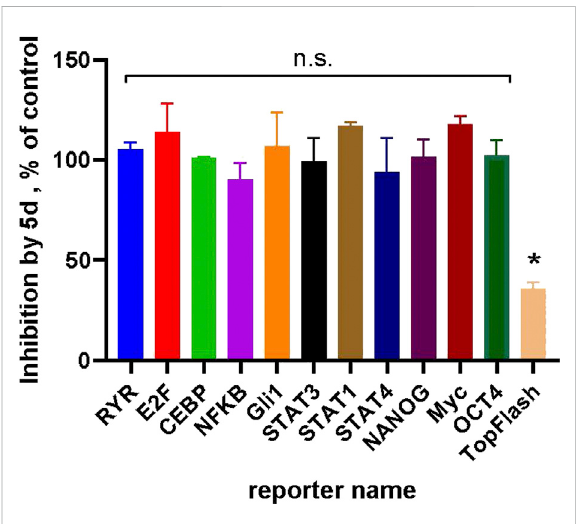
FIGURE 5 Compound5d(at5 µM)demonstratesselectivitytowardsthe Wnt-pathway: no inhibition in a panel of luciferase reporters with measurable basal activities in HCC1395 cells could be observed by the compound. Inhibition of the Wnt3a-stimulated TopFlash signal is shown as a positive control. Statistical signi fi cance was assessed by one-sample t -test and is shown as * p < 0.05; “ n.s. ”— not signi fi